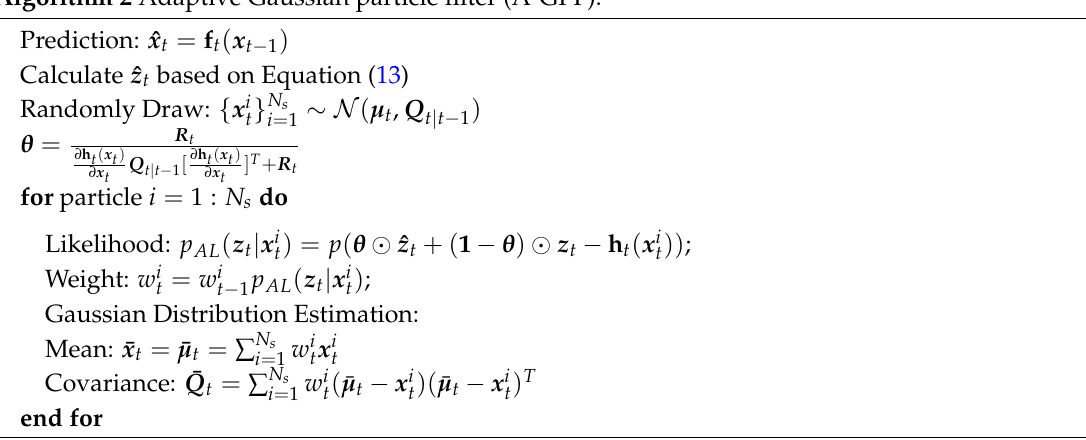
Algorithm 2 Adaptive Gaussian particle filter